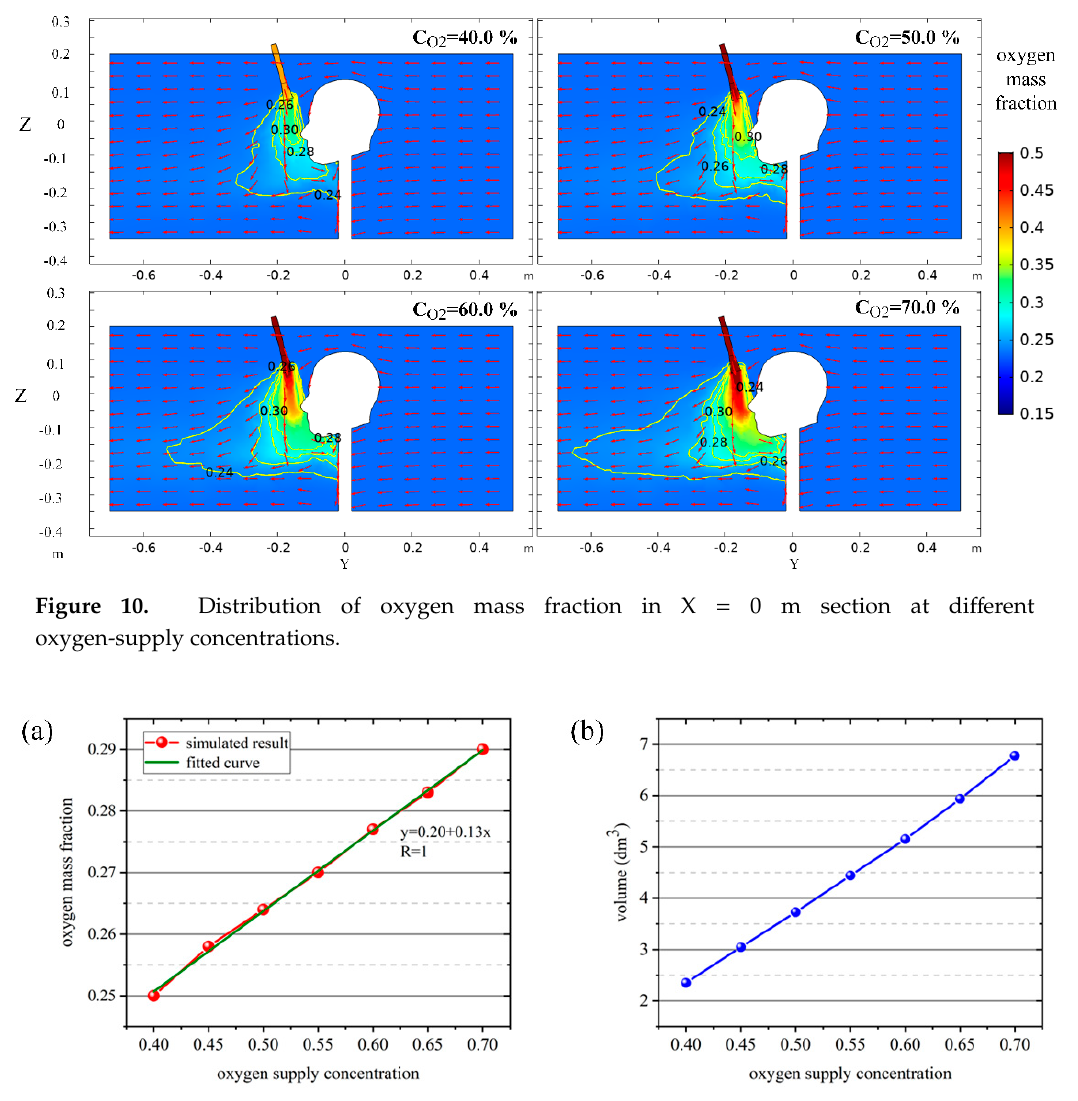
Figure 11. ( a ) Fitted curve of oxygen mass fraction of the air inhaled by human at different oxygen-supply concentrations. ( b ) Volumetric distribution of regions with oxygen mass fraction up to 24.35% at different oxygen-supply concentrations.